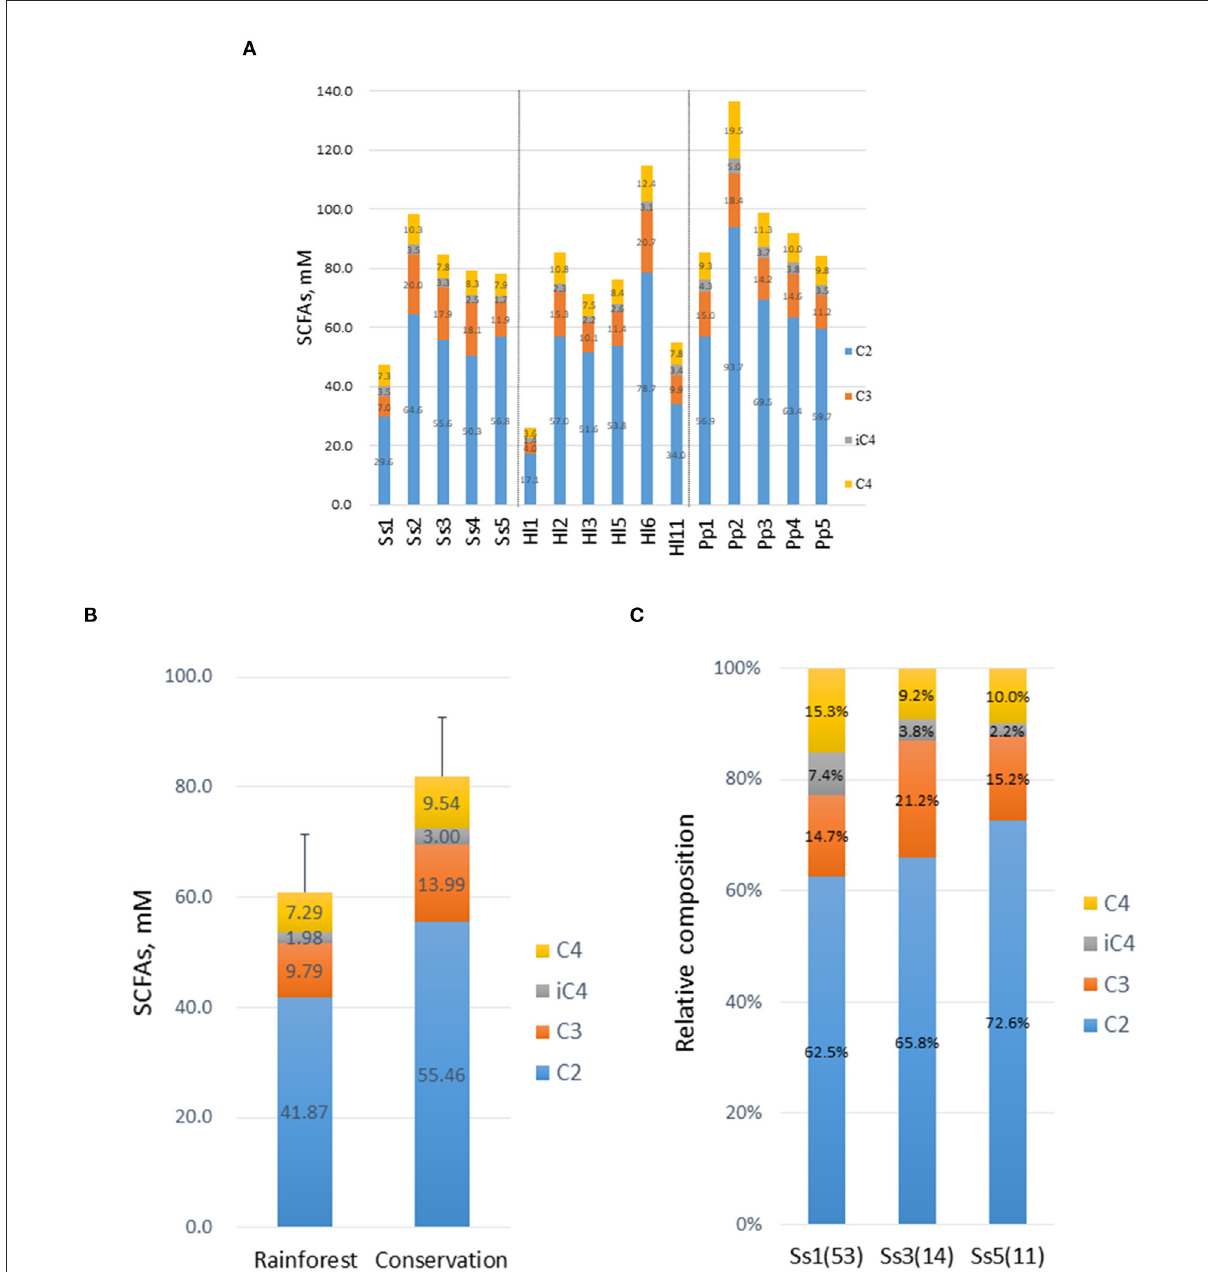
FIGURE5 Composition and concentration of short-chain fatty acids (SCFAs) in feces. (A) Concentrations of SCFAs, acetic acid (C2), propionic acid (C3), isobutyric acid (iC4), and butyric acid (C4) were determined. (B) Concentrations of SCFAs in white-handed gibbons housed in the rainforest area ( n = 3) or the conservation area ( n = 3). (C) Composition of SCFAs in three male siamangs inhabiting the rainforest area. The age of each animal at the time of sampling is indicated in parentheses.